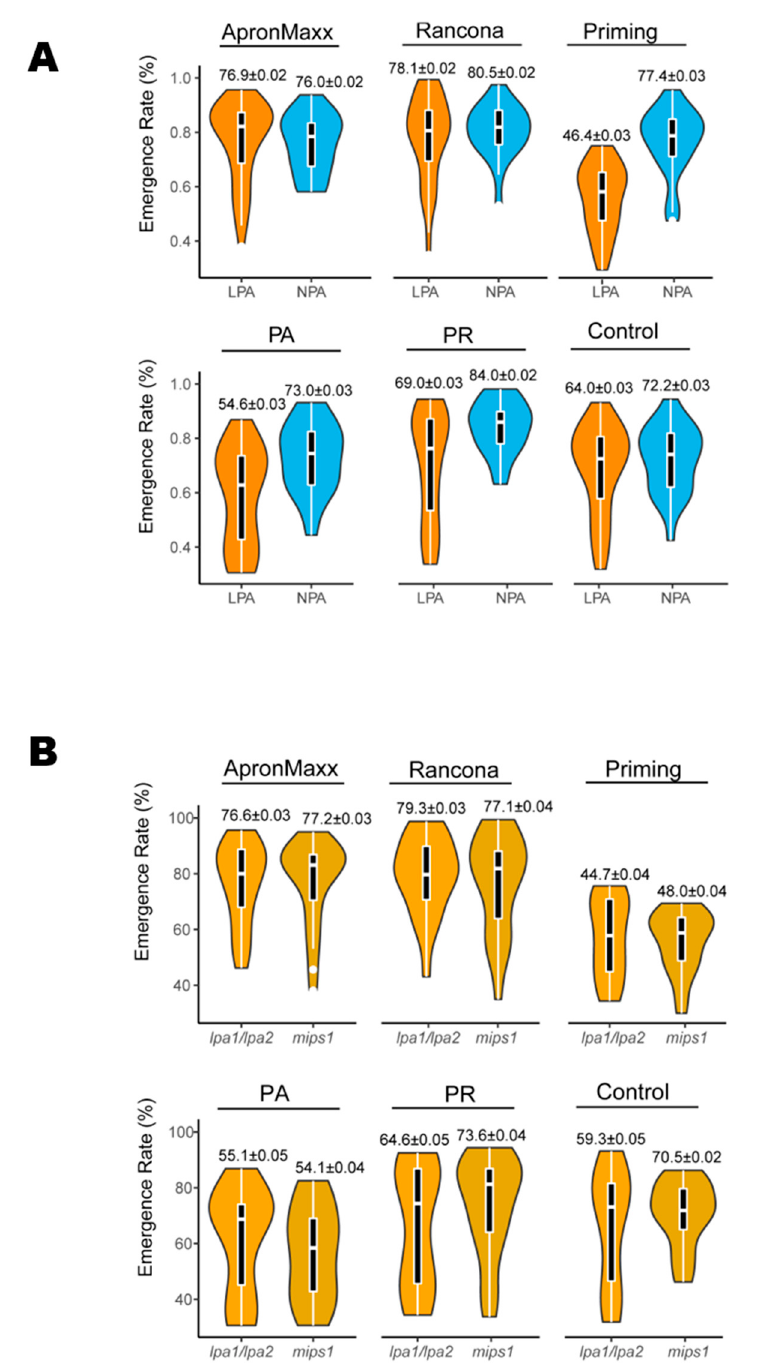
Figure 1. Field emergence for six seed treatments across different soybean varieties grown in 2015. Emergence rates of four low phytic acid (LPA) and two normal phytic acid (NPA) soybean varieties ( A ) as well as two LPA varieties with lpa1 and lpa2 alleles and two other LPA varieties with the mips1 allele ( B ) were calculated. White horizontal lines at the center of each box show median values. The bounds of each black box show the quartiles, and the upper and lower bars show the maximum and minimum values, respectively. This image was drawn using ggplot2 package. Numbers above the violin plot indicate the means ± standard deviations. PA: Priming + Rancona; PR: Priming + ApronMaxx.